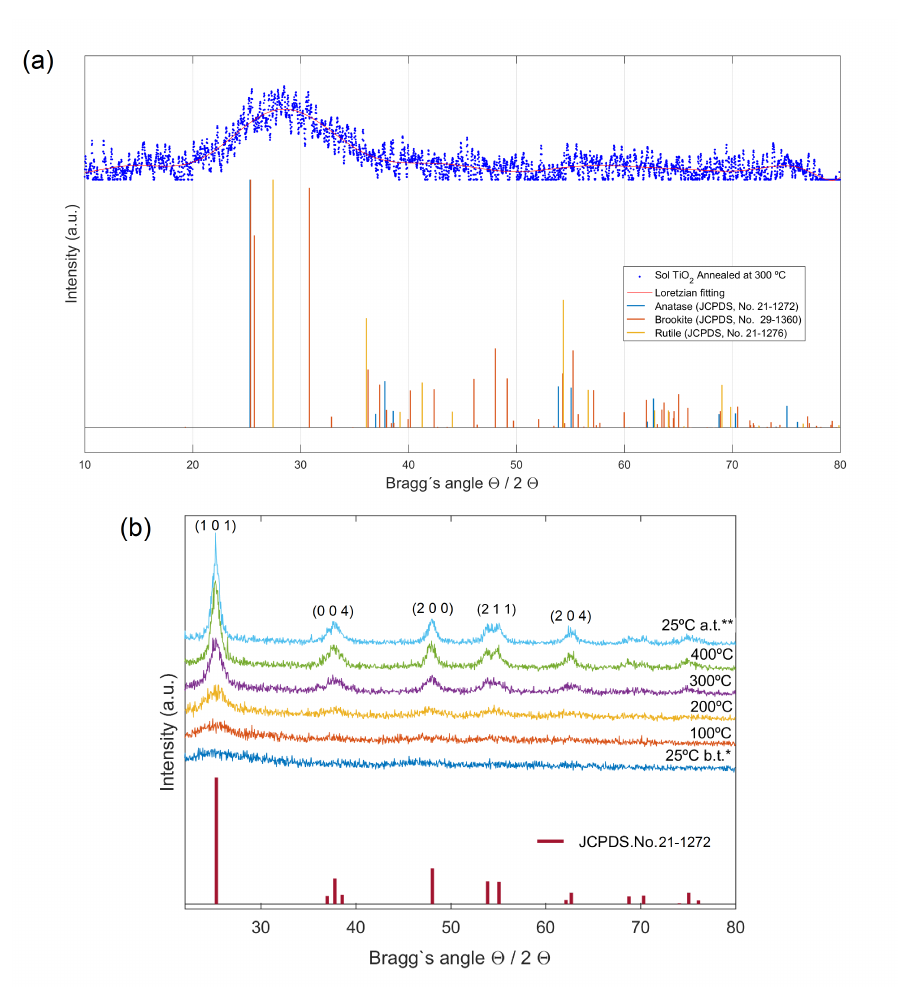
Figure 1. ( a ) XRD spectra of nano-TiO samples prepared by sol-gel synthesis at ambient temperature 2 followed by calcination at 300 ◦ C. XRD data was fitted with Gaussian–Lorentzian function (G/L = 30) and variable FWHM. Despite poor crystallinity, multiple phases were detected in these samples. ( b ) XRD patterns of as prepared sol-gel nano-TiO sample during the heating period from 25 to 400 ◦ , 2 recorded at different temperatures (*25 ◦ C b.t. (before thermal treatment), 100 ◦ C, 200 ◦ C, 300 ◦ C, 400 ◦ C and **25 ◦ C a.t. (after treatment). The presence of crystalline anatase is identified in the samples heat-treated from 200 up to 400 ◦